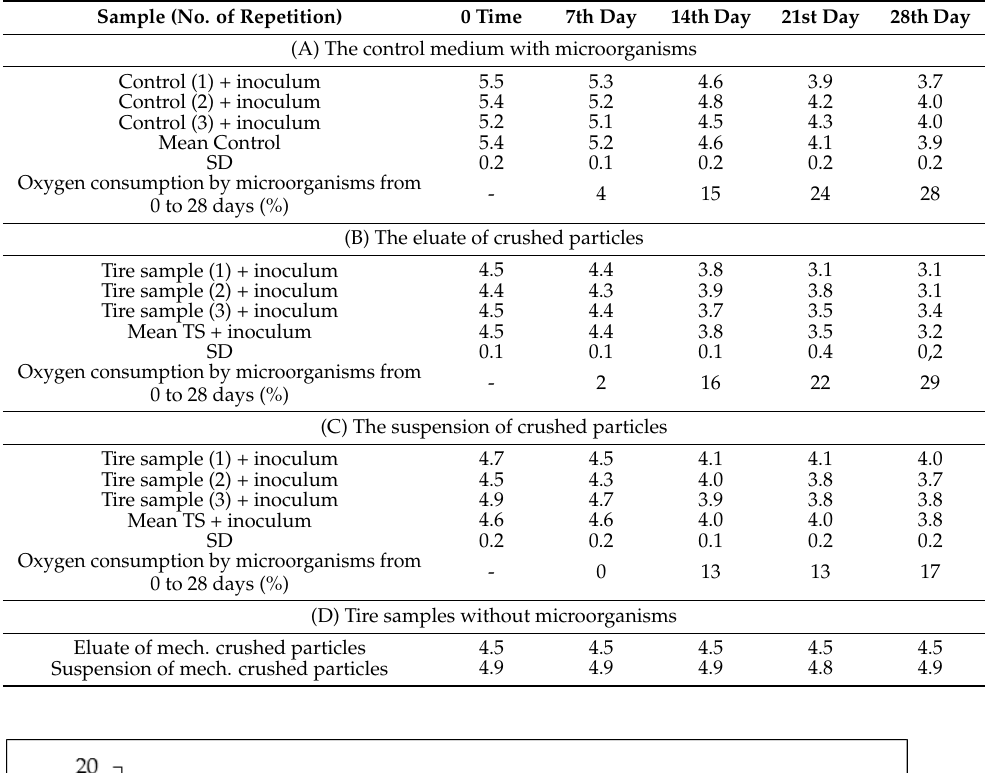
Table 1. Measured values of O 2 (mg/L) and their mean + standard deviations (SDs) of the controls and of the tested samples with microbial inoculum and without microbial inoculum.